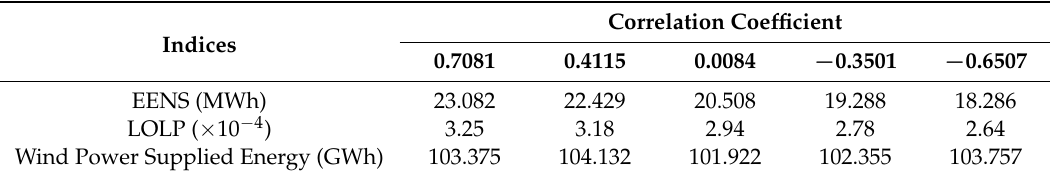
Table 5. Comparison on the results of the five cases.